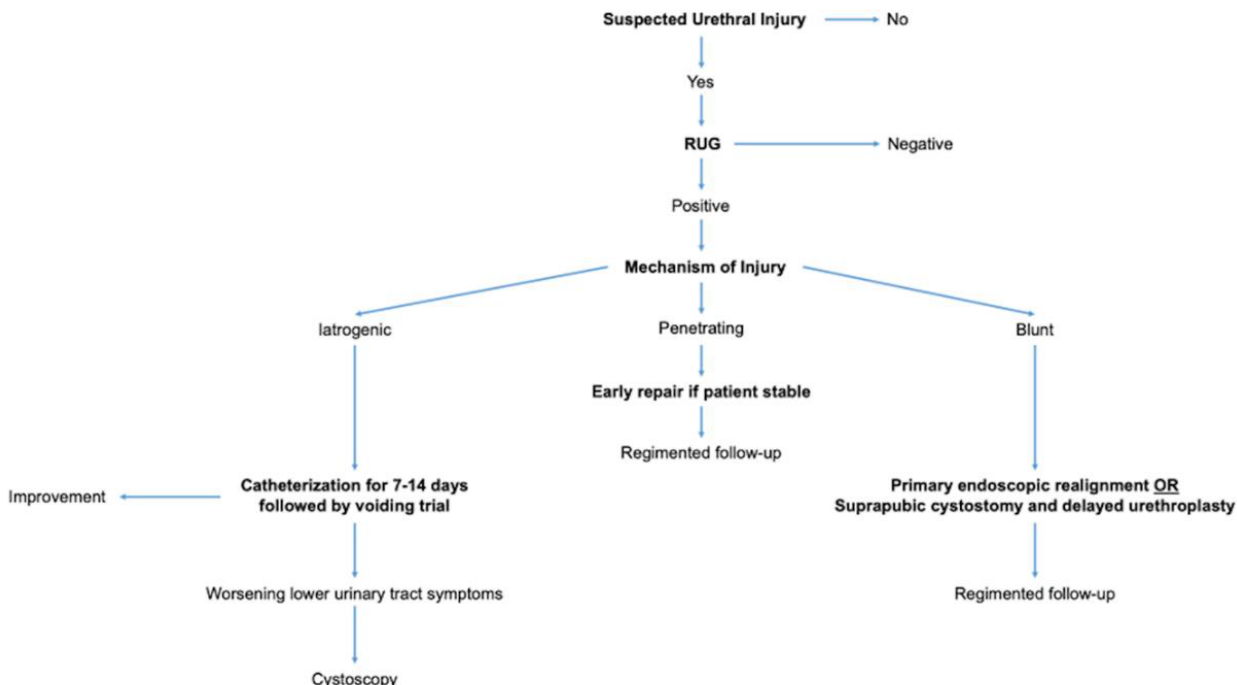
Figure 3. Diagnostic and Treatment Algorithm for Urethral Injury.